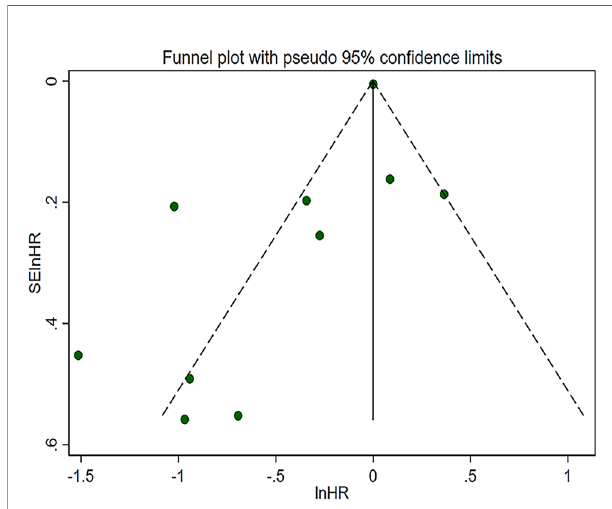
FIGURE 4 | Funnel plot with pseudo 95% con fi dence limits of pooled overall survival. HR, hazard